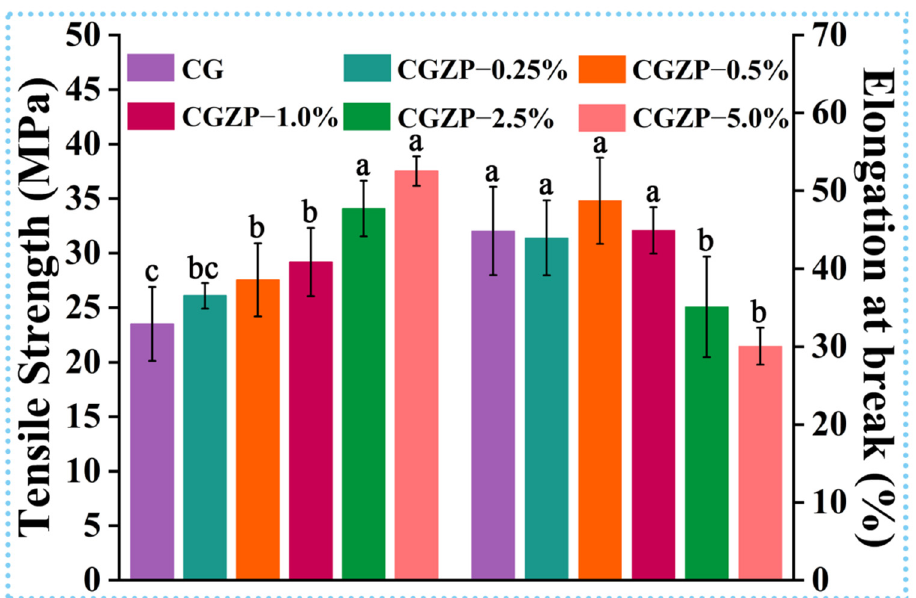
Figure 3. Tensile strength and Elongation at break of CG and CGZP films. Different letters in the columns indicate significant difference ( p < 0.05).